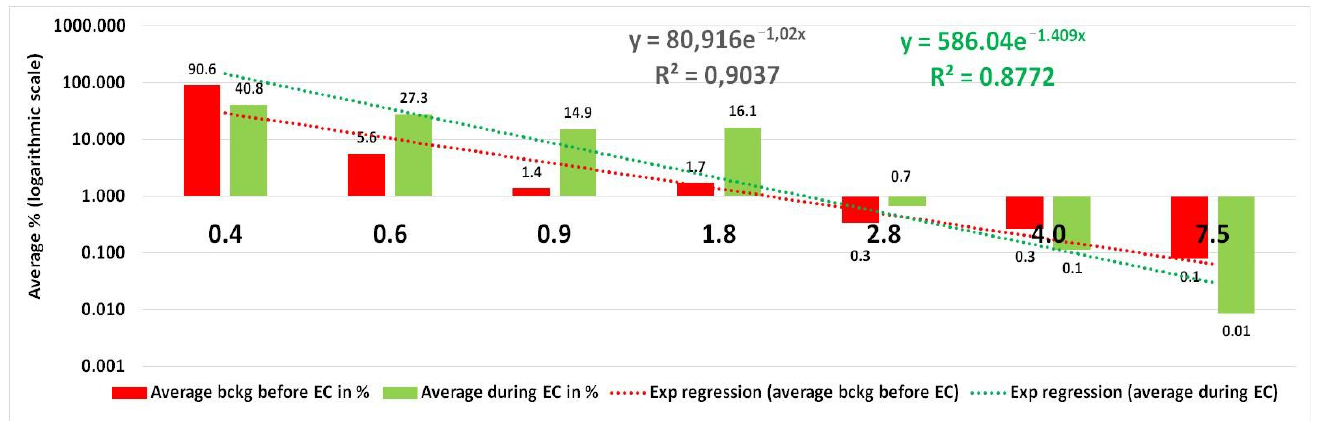
Figure 5. ECSHA profile comparison between background and during use of “JustFog” e-cigs.